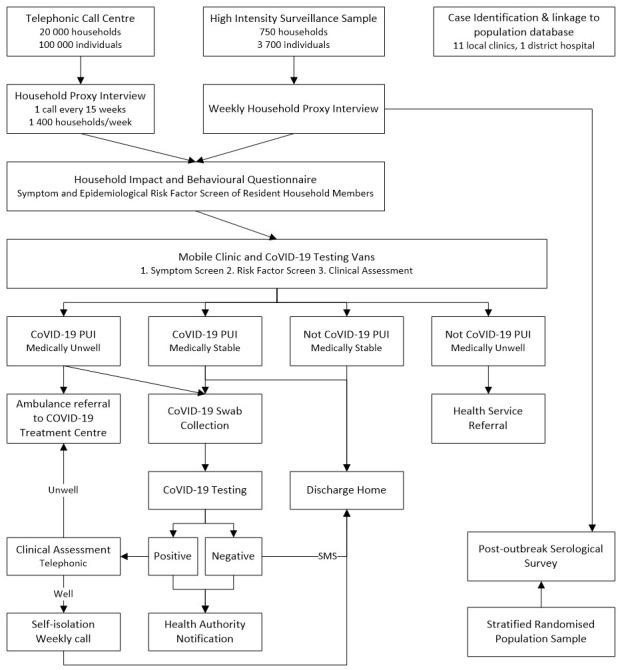
Study flow diagram.